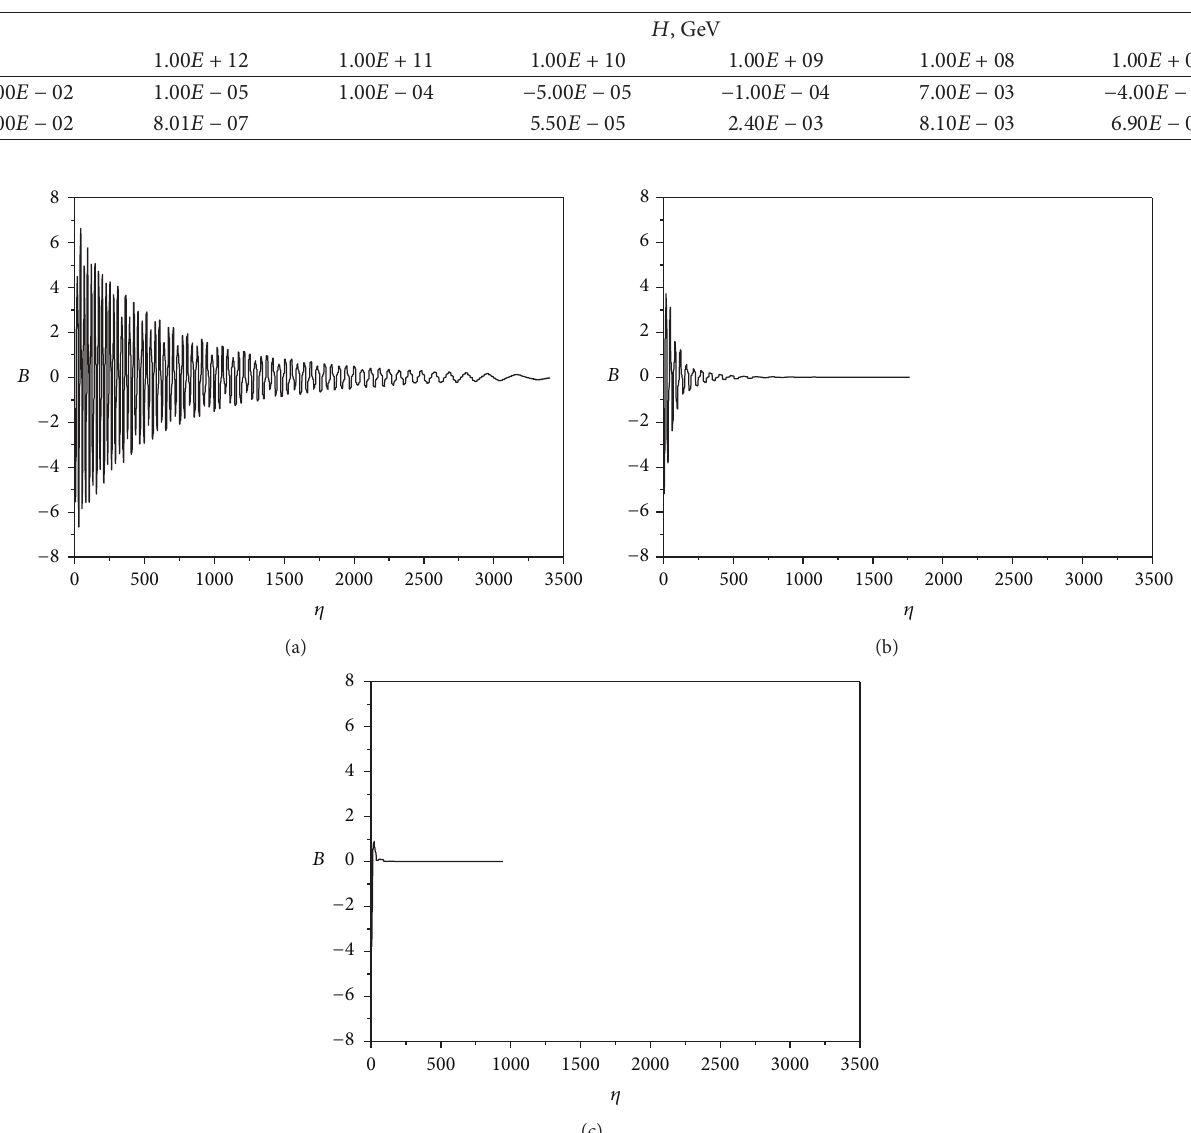
Table 3: The baryon charge 𝐵 contained in the SFC at the time of its decay for different 𝛼 and 𝐻 𝐼 and 𝜆 1 = 5 × 10 −2 , 𝜆 2 = 𝜆 3 = 10 −3 , = 𝐻 𝜆 −1/4 , and ̇𝜑 = 𝐻 𝐼2 . 𝑚 = 350 GeV, 𝜑 𝑜 𝐼 𝑜